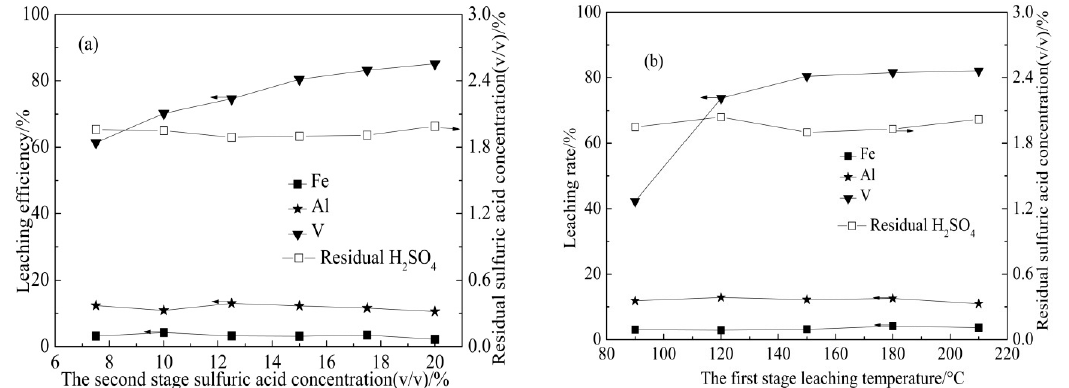
Figure 6. Effects of the acid pressure leaching (II) parameters on leaching efficiency of V, Al, P, Fe. ( a ) The sulfuric acid concentration of the second stage; ( b ) the leaching temperature of the second stage.